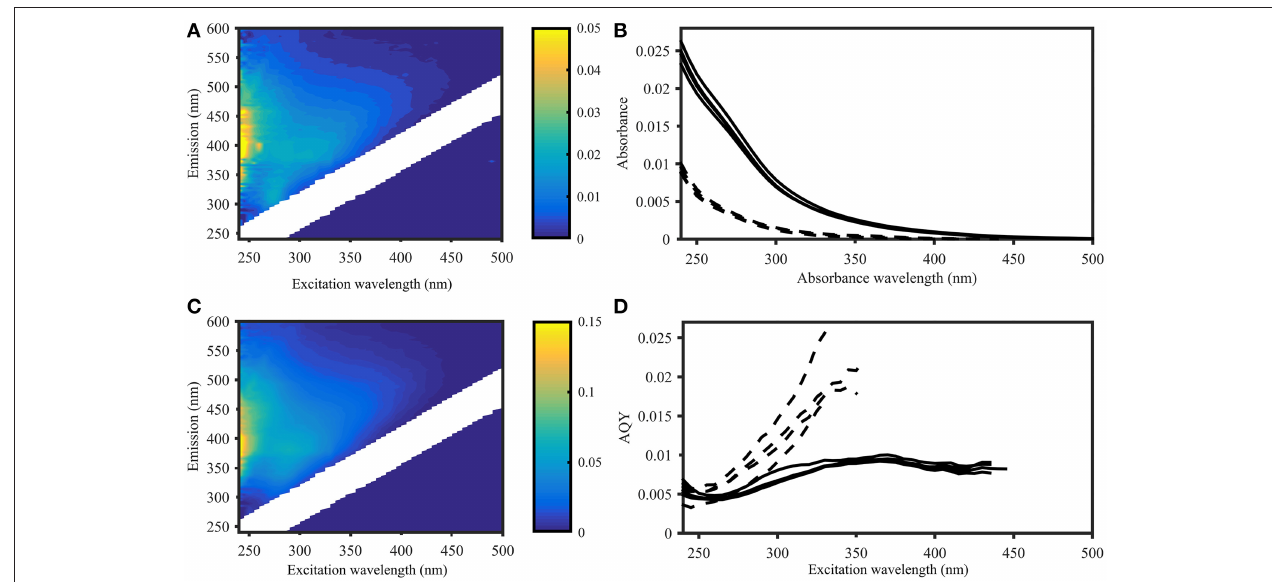
FIGURE 2 | Apparent quantum yield and fluorescence in samples from the Norwegian Sea (Station 2, deep sea) and Skagerrak (Station 14, surface water). Left panel: EEMs of deep (A) and surface (C) samples in Raman units (different scales as indicated by colorbar). Right panel: CDOM absorbance (B) and CDOM apparent fluorescence quantum yields (D) of four deep sea samples (dashed lines) and four surface water samples (solid lines), showing deep sea AQYs consistently higher than in surface waters. AQYs at wavelengths where signal to noise ratios were below 25 are missing values.